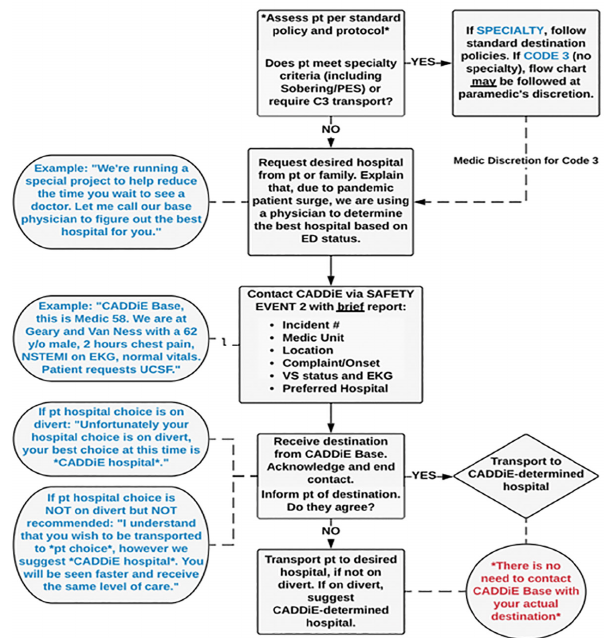
Figure 1. Flow Diagram with instructions on how to contact CADDie and how to assist with destination determination. Pt, patient; PES, Psychiatric Emergency Services; CADDIe, c entralized ambulance destination-determination; ED,